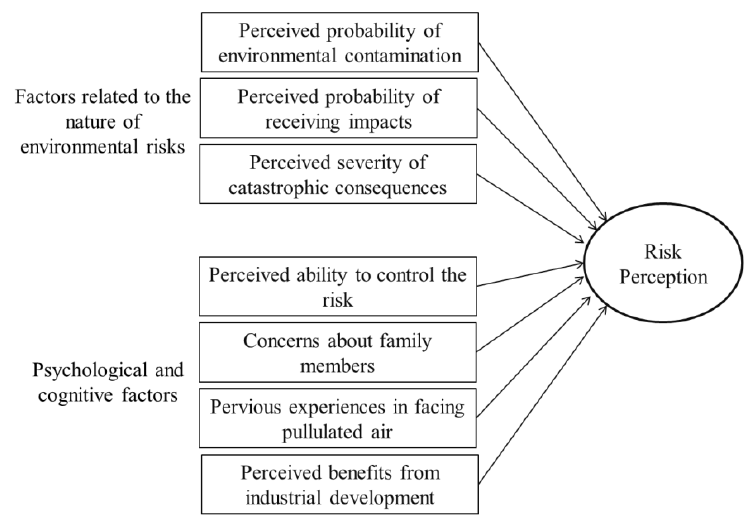
Figure 1. Conceptual model of risk